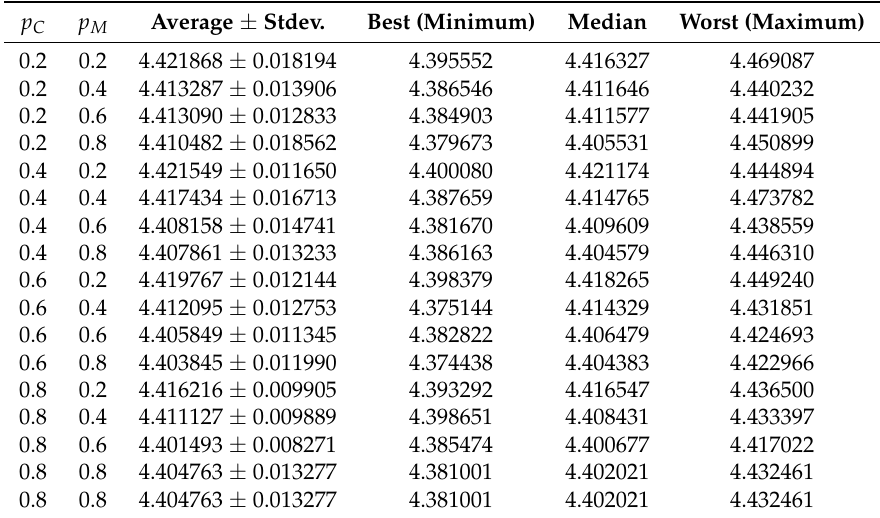
Table 2. Parameterization results for weekend instances—final fitness